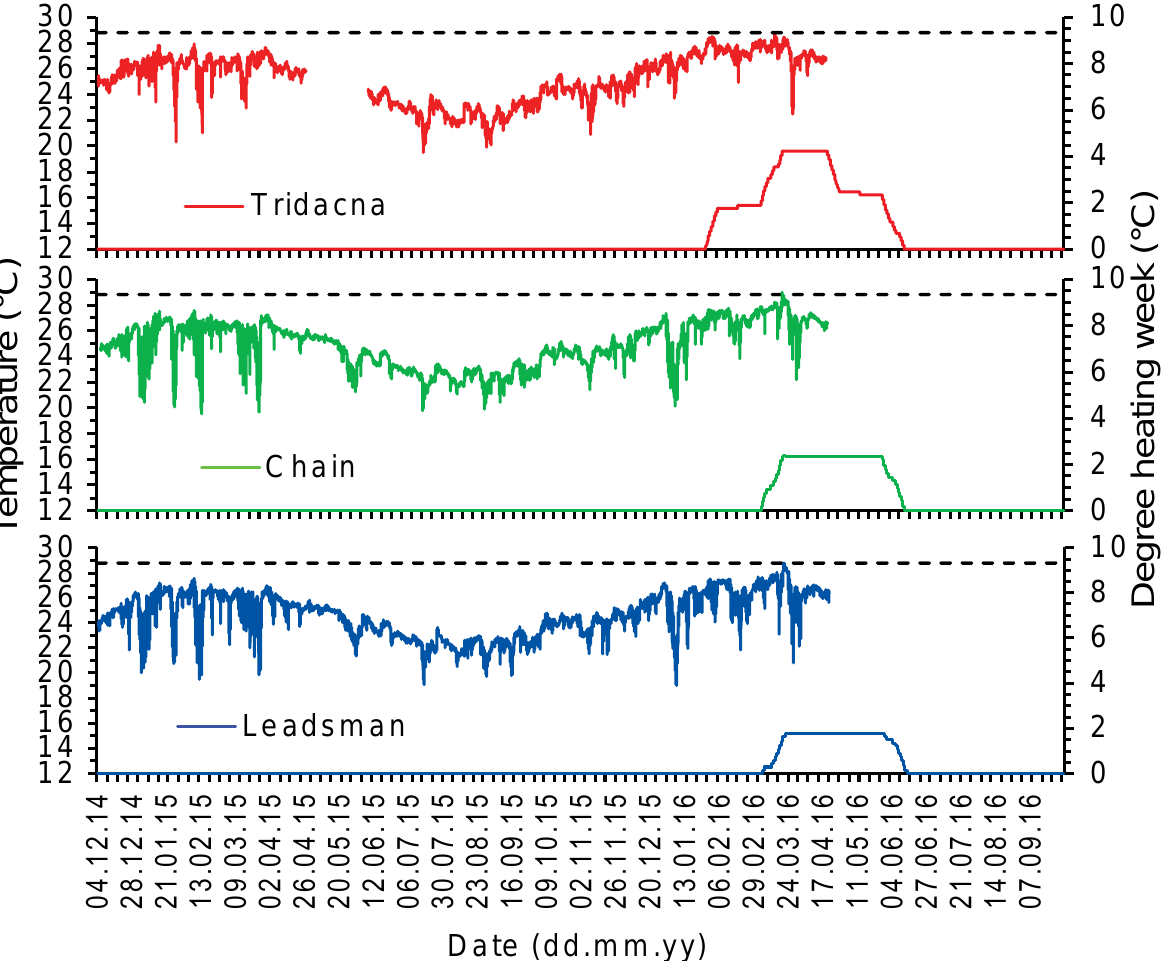
Figure 4. Temperature timeseries and degree heating weeks at Tridacna, Chain and Leadsman Shoal in Maputaland, South Africa during bleaching surveys conducted in December 2015, April – May 2016 and September 2016. The dashed line indicates the local bleaching threshold temperature [21].